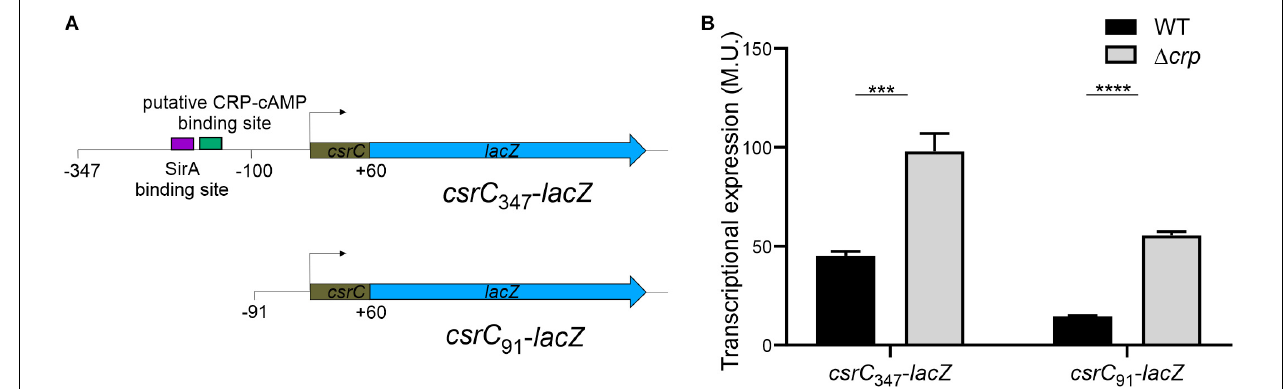
FIGURE 3 | CRP-cAMP represses CsrC in absence of SirA binding site. (A) Diagram of the lacZ transcriptional fusions present in the pQF csrC and pQF csrC-91 plasmids. The csrC upstream sequences cloned in pQF50, –347/ + 60 and –91/+60, are depicted. The relative position of the SirA binding site and the putative CRP-cAMP binding site are indicated with a purple and green rectangle. (B) Transcriptional expression of the lacZ fusions described in A in WT and (cid:49) crp genetic backgrounds. In all cases, cultures were grown in LB at 37 ◦ C up to an OD 600 nm of 0.4. β -galactosidase activity was determined for three independent cultures, average and standard deviation are presented. *** p < 0.001; **** p <